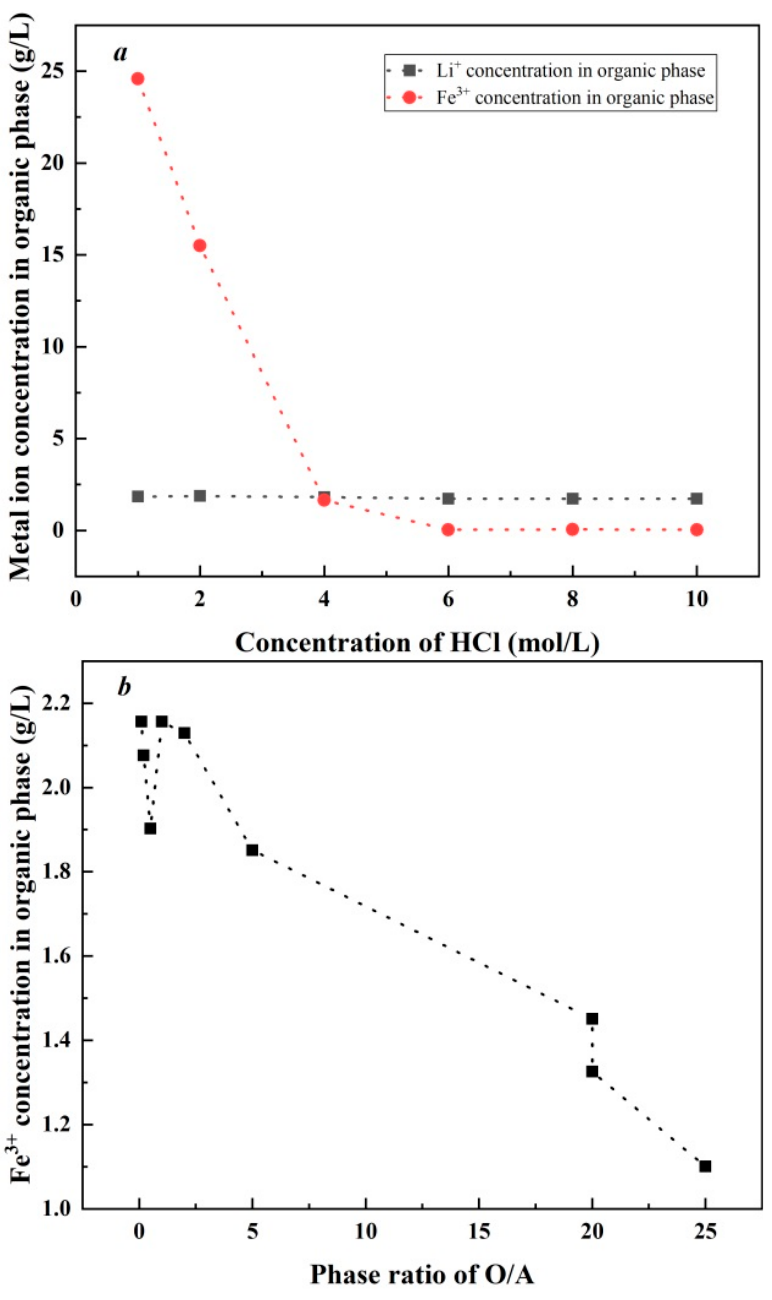
Figure 7. Effect of stripping condition. (( a ) means the effect of concentration of HCl and ( b ) means the effect of phase ratio of